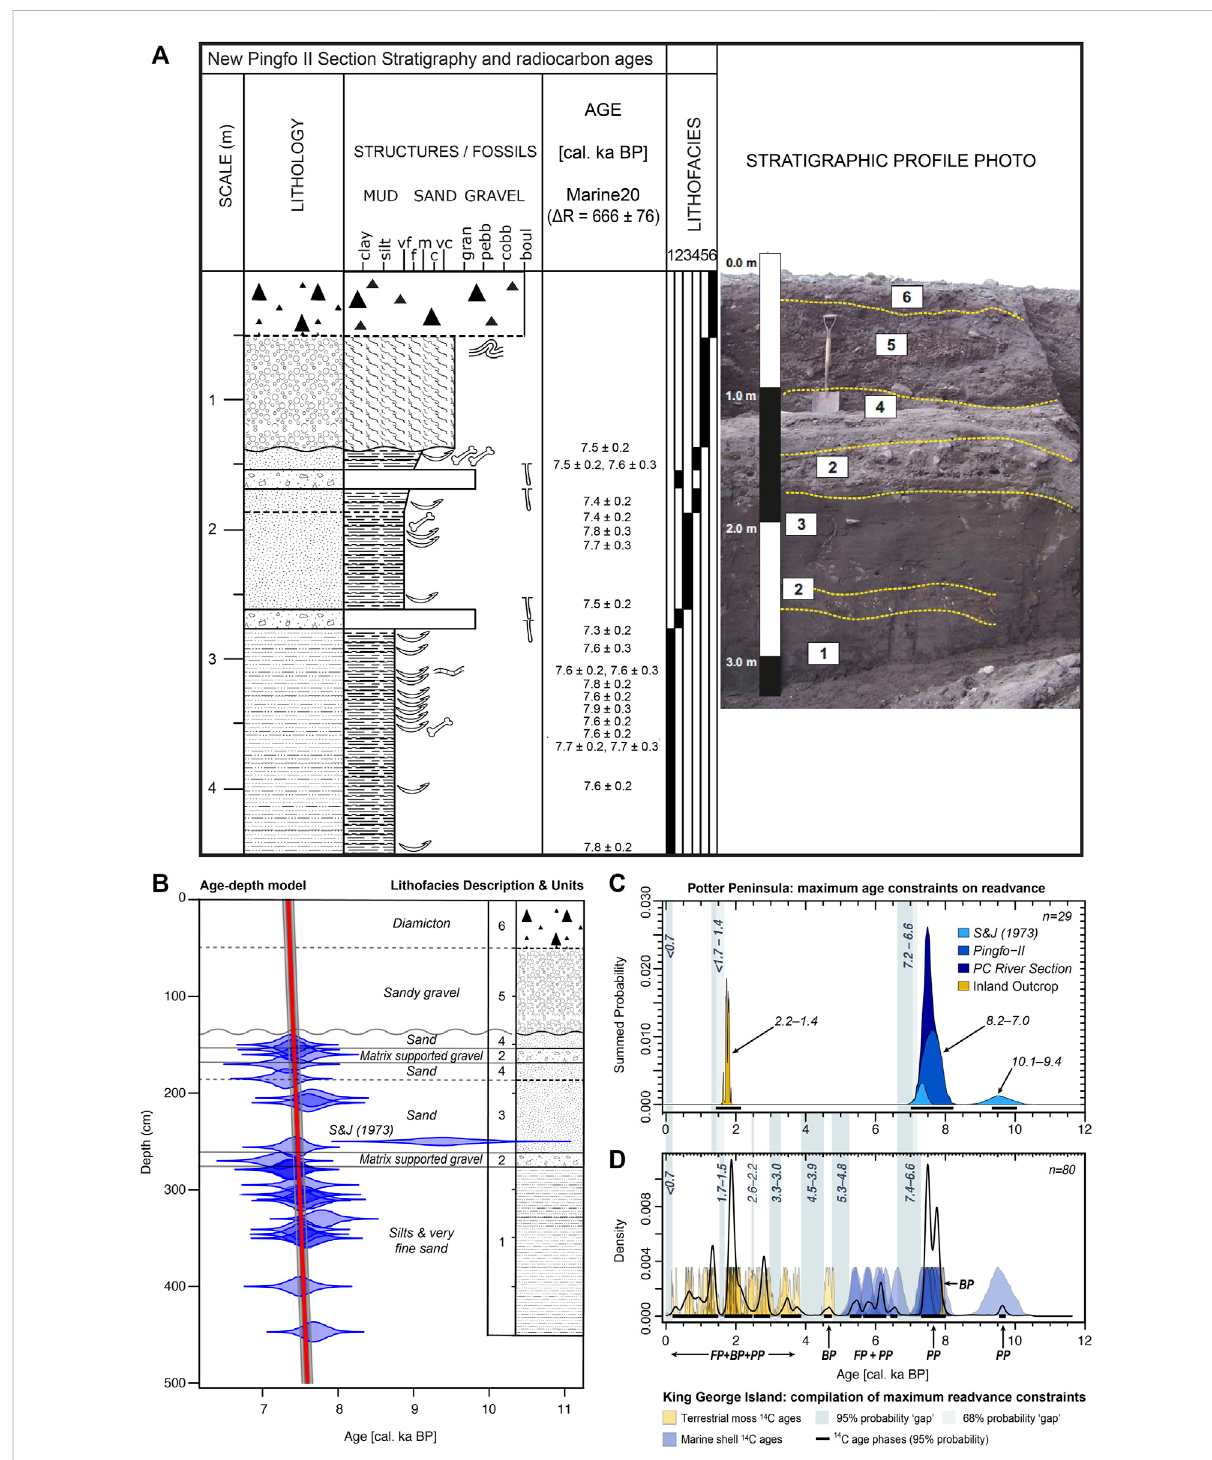
FIGURE 6 (A) Stratigraphic pro fi le and photograph of the new Pingfo II section. Lithofacies units 1 – 6 shown in the photo are described in the main text. Legend is as shown in Figure 5. (B) Bayesian (BACON) age-depth model for the new Pingfo II and River Cut sections showing that new radiocarbon age data arebroadlyin stratigraphic order,with mean values clustering between7.8 and 7.5cal. ka BP(8.0 – 7.0cal.ka BP95%probability density age range). The older age range of10.1 – 9.4 cal. ka BP (95% probability density age range) is based on ages reported by Sugden and John (1973) and is a clear outlier. Lithofacies units 1 – 6 are as shown in (A) . See Table 2 for radiocarbon data. (C) Summed probability pro fi le of new radiocarbon age data from Potter Peninsula in this study compared with previously published data (S&J, Sugden and John, 1973) in Table 2. (D) Probability